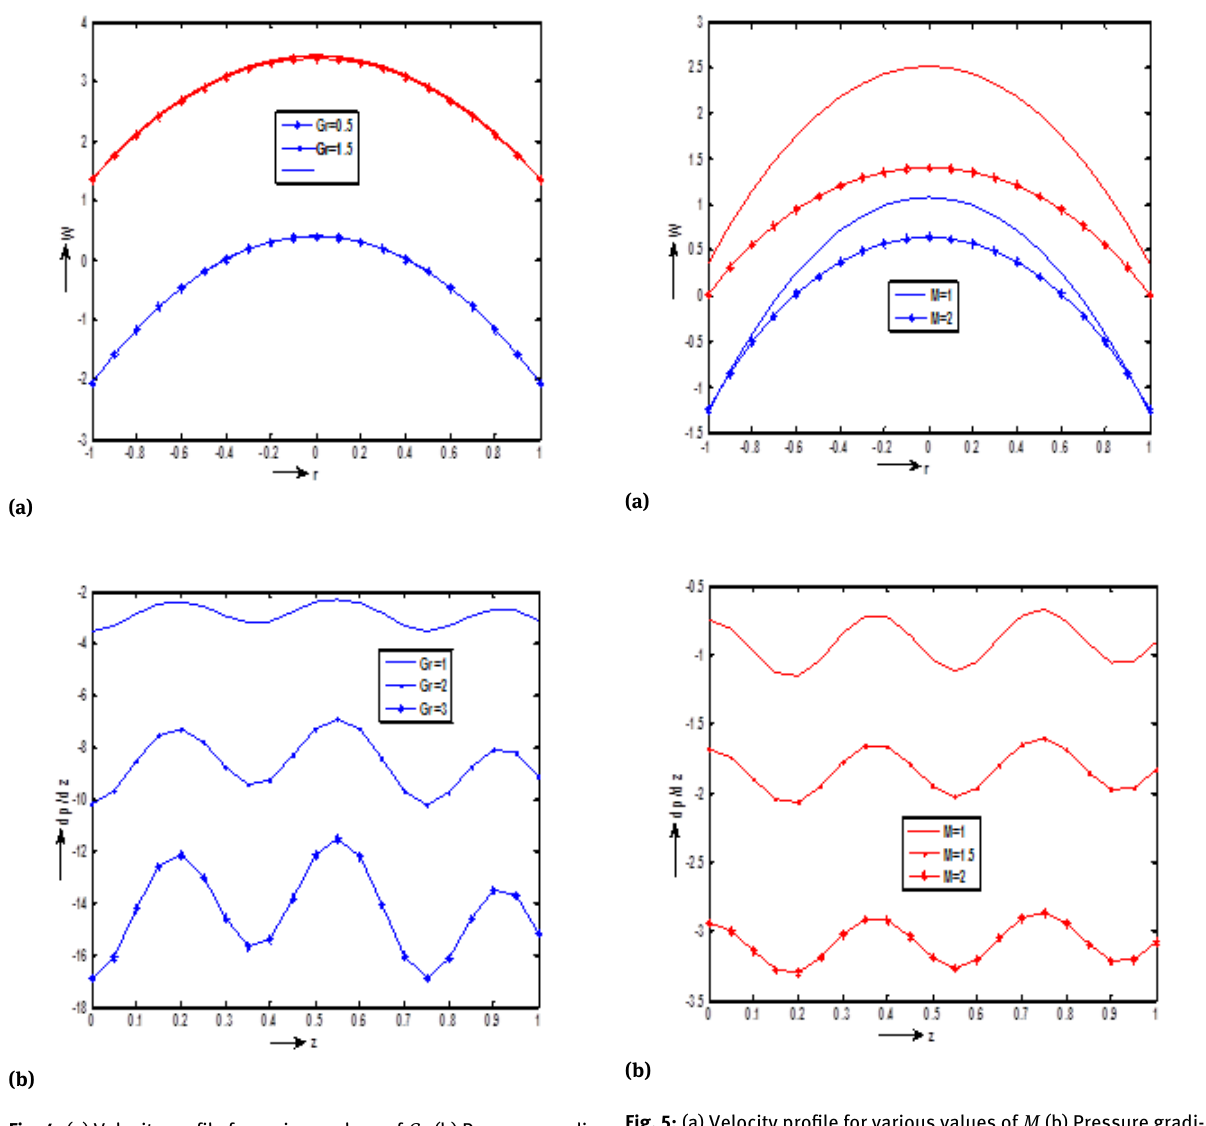
Fig. 4: (a) Velocity profile for various values of Gr (b) Pressure gradi- ent for various values of Gr